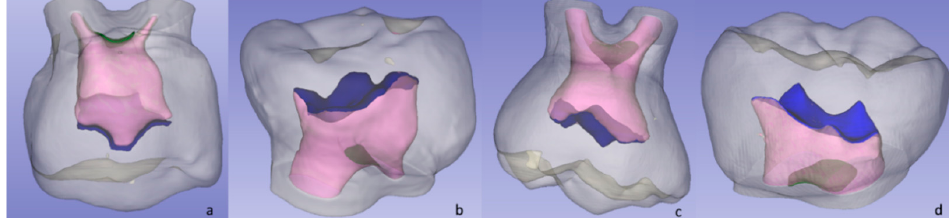
Figure 1. Three-dimensional reconstruction: ( a ) primary maxillary first molar (P1MS); ( b ) primary mandibular first molar (P1MI); ( c ) primary maxillary second molar (P2MS); and ( d ) primary man- dibular second molar (P2MI).